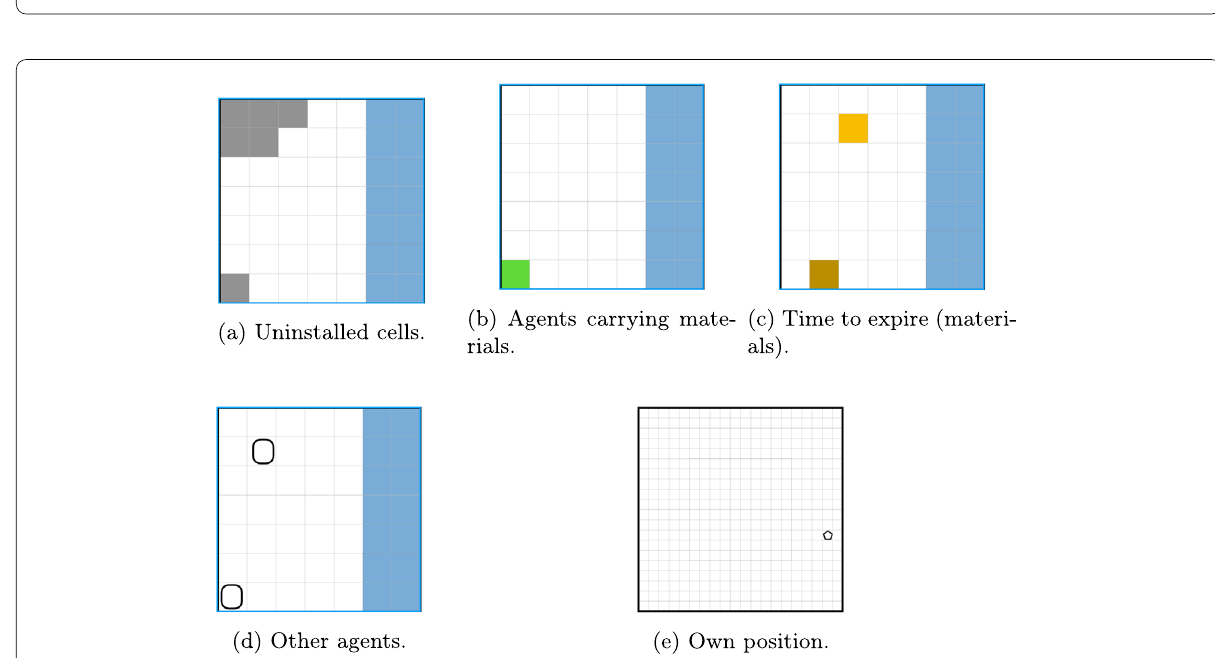
represented by three digits ( b 1 , b 2 , b 3 ) (where b k ∈ { 0,1,–1 } and ∃ k s.t. b k (cid:16) = 0) and b k is the element of the k th matrix at the agent’s location. (0,0,0) indicates that no agent exists at the corresponding cell. Finally, Figs. 2(b) and 3(b) rep- resent the position of the materials being carried by the carrier agents, and the element in the second type of ma-